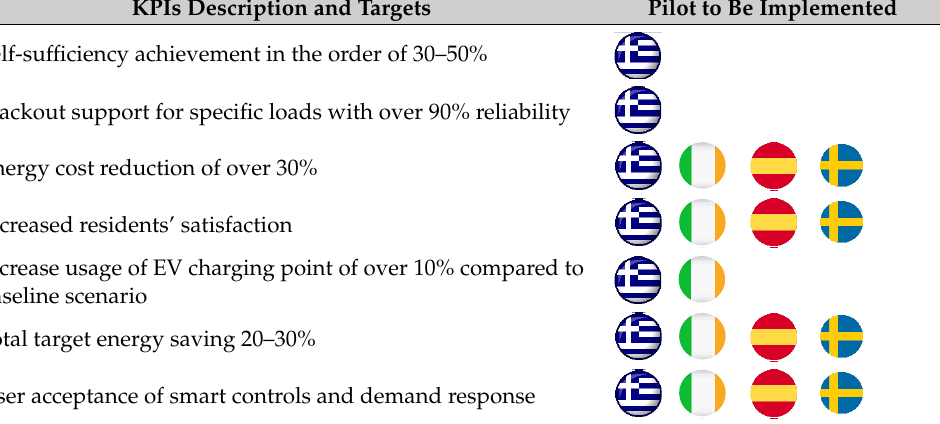
Table 4. Pilots’ KPIs.